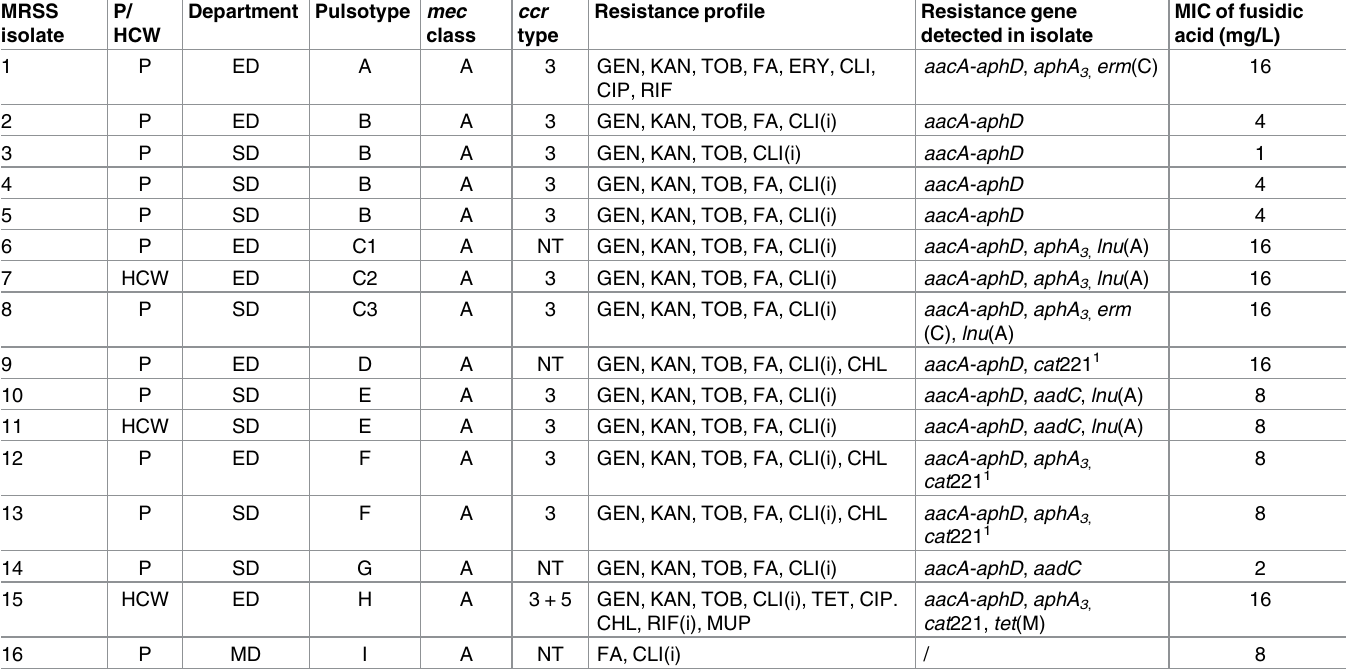
Table 3. Characteristics of methicillin-resistant Staphylococcus sciuri strains isolated from nasal and throat swab specimens obtained from hos- pitalised patients and healthcare workers (HCWs). MRSS P/ isolate